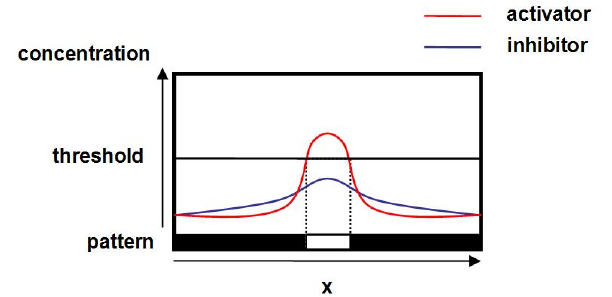
Figure 2 . Concentration distribution of activator and